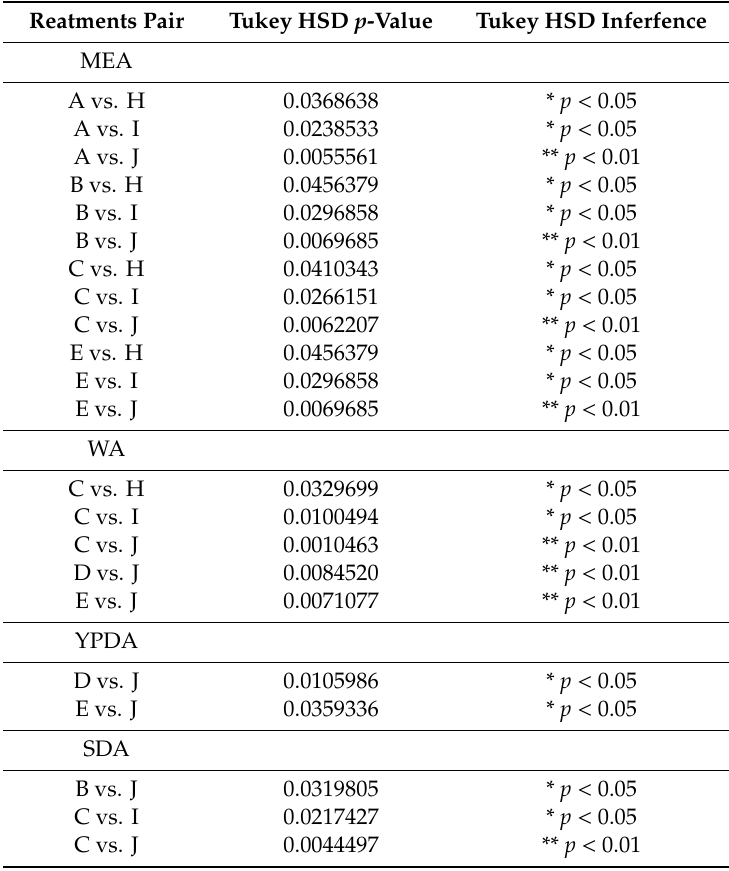
Table 6. Significant di ff erences among analyzed federweisser samples for individual cultivation